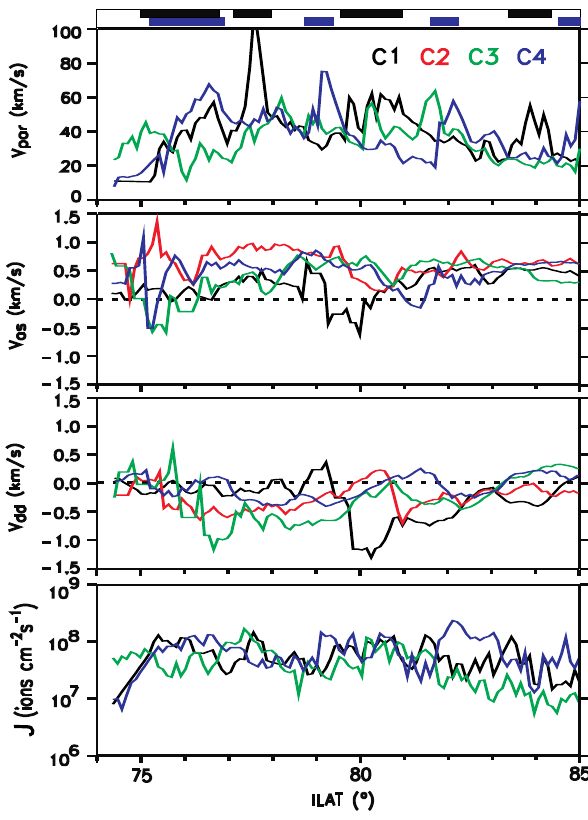
Fig. 6. Plots of particle moments as a function of invariant latitude on 14 August 2001. The format is the same as that in Fig. 4.